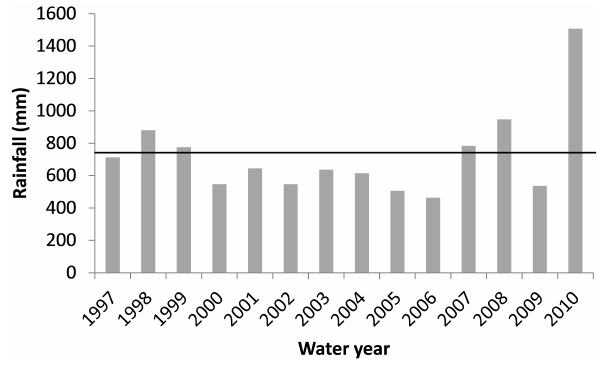
Figure 2. Annual rainfall (millimetre per water year) measured at a rainfall station near the Wivenhoe and Somerset reservoirs (Bu- reau of Meteorology, bom.com.au). Horizontal line shows long- term mean